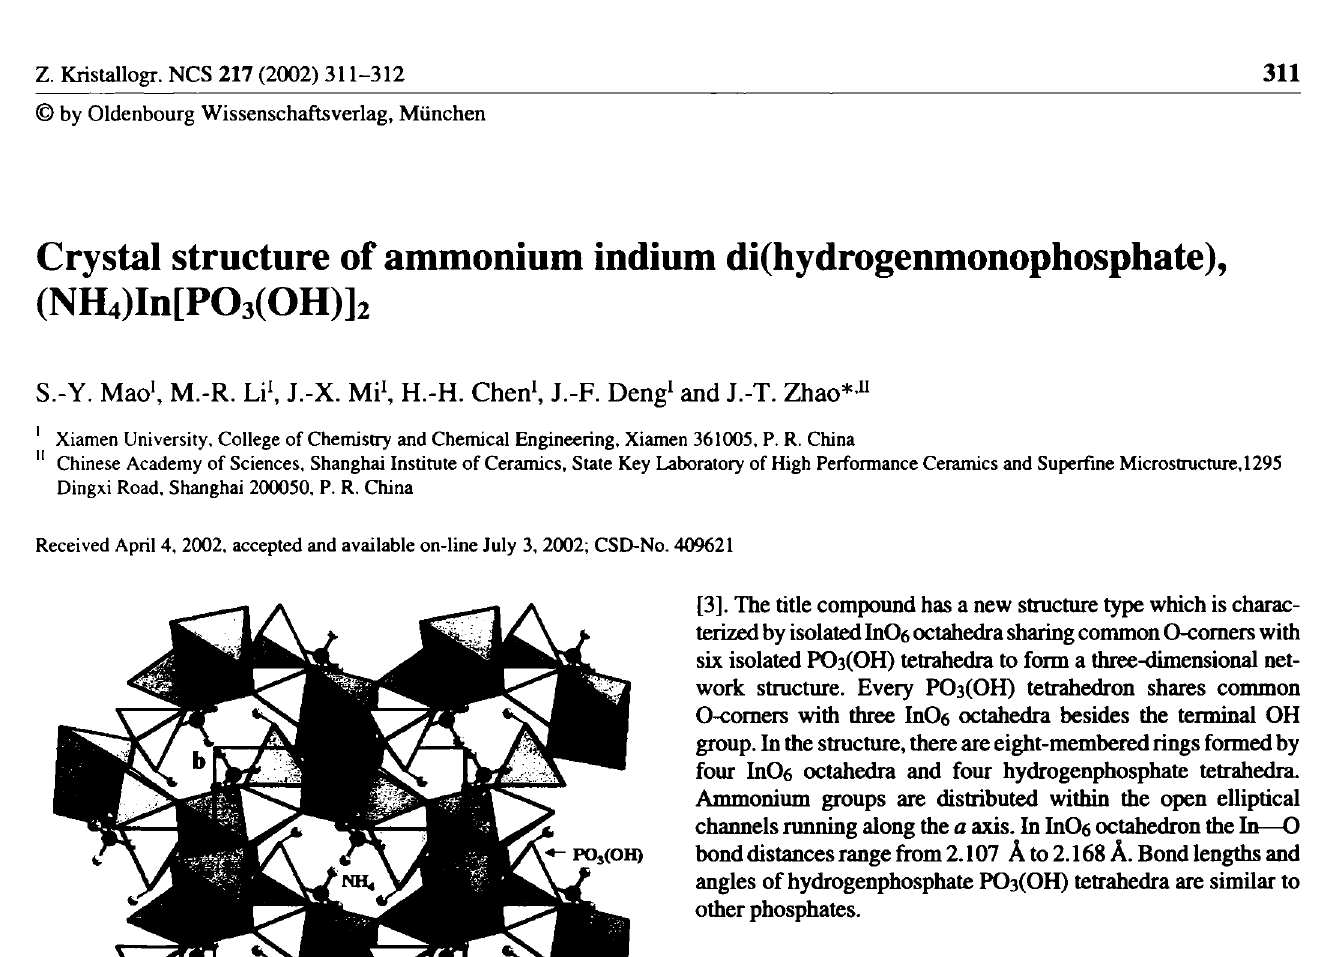
Table 2. Atomic coordinates and displacement parameters (in Ä 2